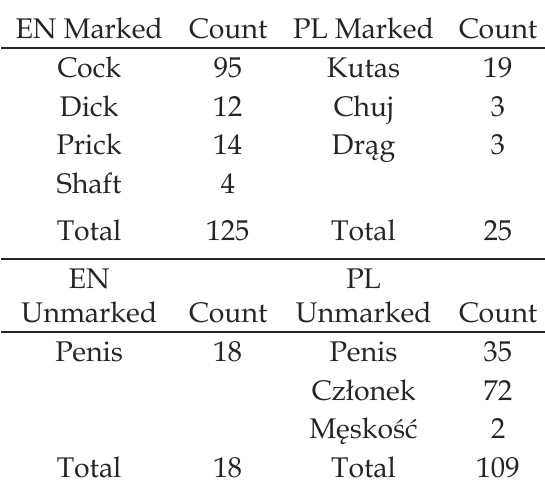
The distribution of marked and unmar- ked vocabulary items related to